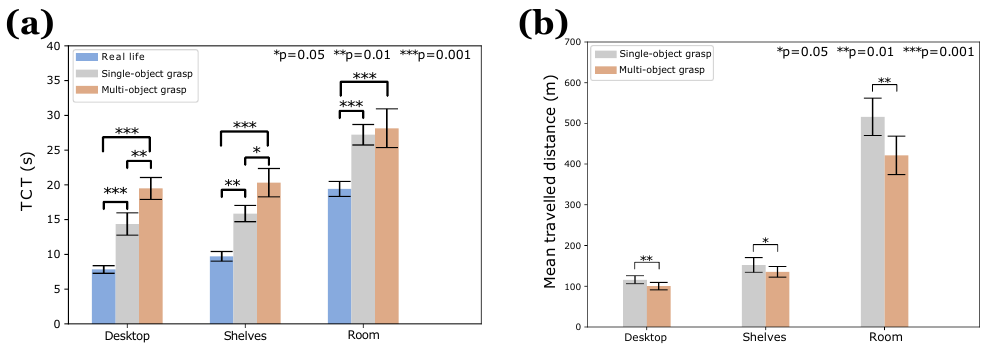
Figure 5. Objective measurements split by condition and scenario: ( a ) task completion time—TCT; ( b ) distance travelled by the hands. Error bars indicate standard